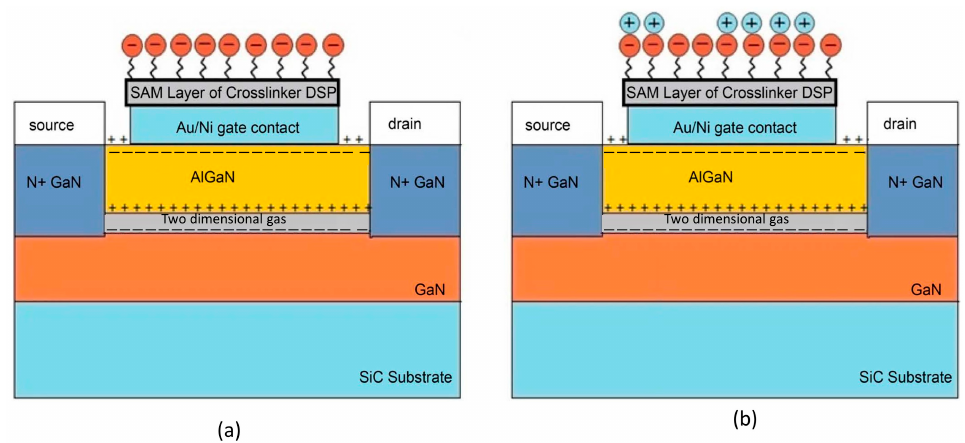
Figure 12. Schematic diagram of ( a ) immobilization of anti-MIG receptors and ( b ) conjugation of MIG antigen on the proposed sensor. Reprinted with permission from [165]. Copyright 2016, Journal of Modern Physics.